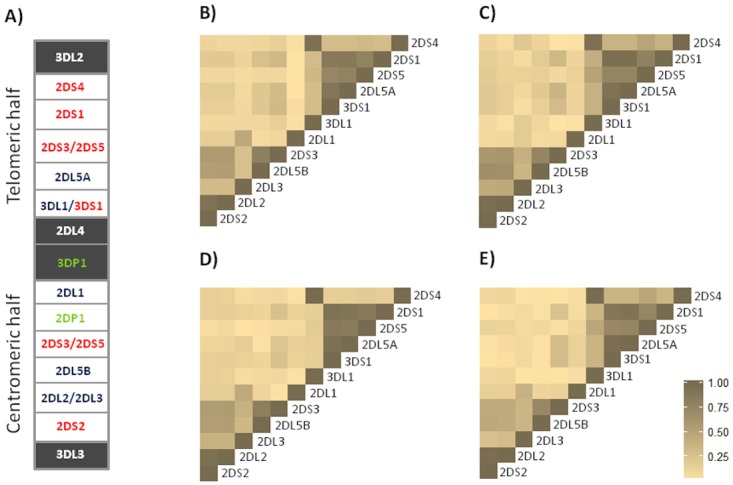
Centromeric and telomeric halves of KIR genotypes (panel A).A stretch of 14 kb DNA that interconnects KIR3DP1 and KIR2DL4 divides the KIR genotype into two halves. The centromeric half is delimited by 3DL3 and 3DP1, while the telomeric half is delimited by 2DL4 and 3DL2. There is different KIR gene content, due to a recombination of these genes, in KIR genotypes across individuals and populations. The framework genes, present in all genotypes are shown in grey boxes; genes encoding activating KIR are in red color; and those for inhibitory receptors are in blue color. KIR2DL4 encodes a receptor that has both inhibitory and activating functions The KIR2DP1 and 3DP1 (green) are pseudogenes that do not express a receptor. Pairwise D’ LD based on Cramer’s V correlation coefficient between the presence and absence of different KIR genes in four groups of patients (panel B-E) B: HCV negative; C: Chronic HCV; D: Hepatocellular carcinoma; E: Lymphoproliferative disease. The KIR cluster genetic polymorphism is considered as the presence or absence of KIR genes.